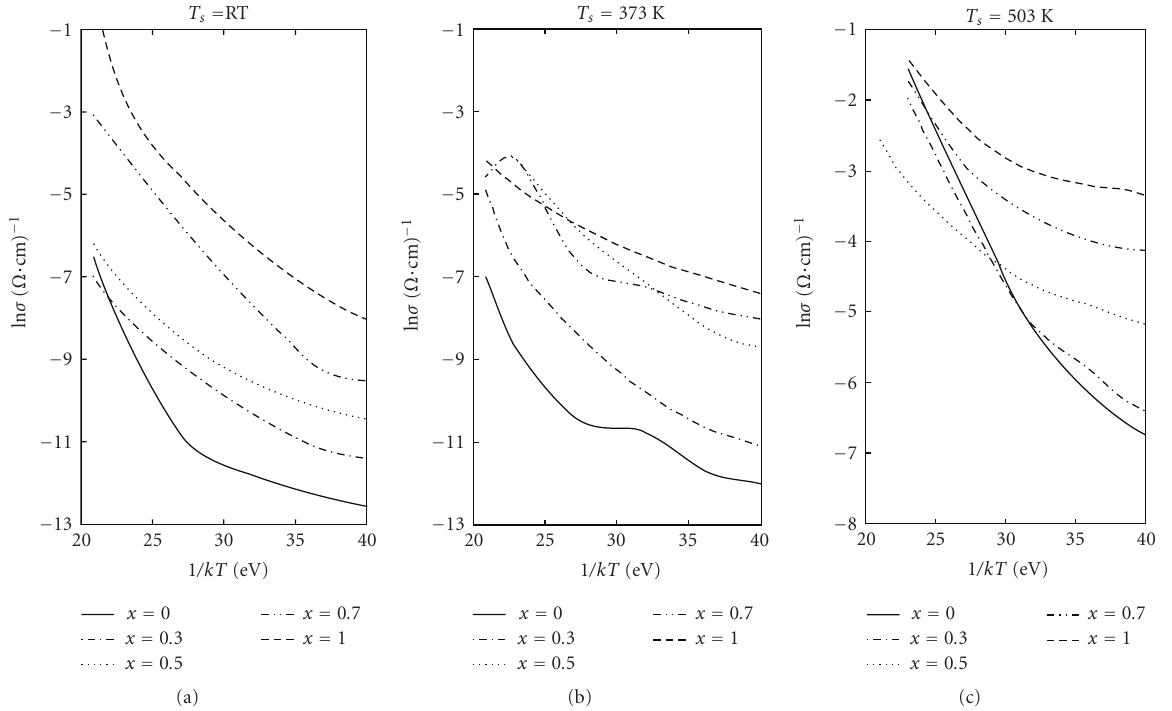
Figure 1: Variation of ln σ with reciprocal of ( kT ) for a-Ge x Si 1 − x :H, thin films, deposited at di ff erent substrate temperatures: (a) RT, (b) 373K, and (c) 503 K.